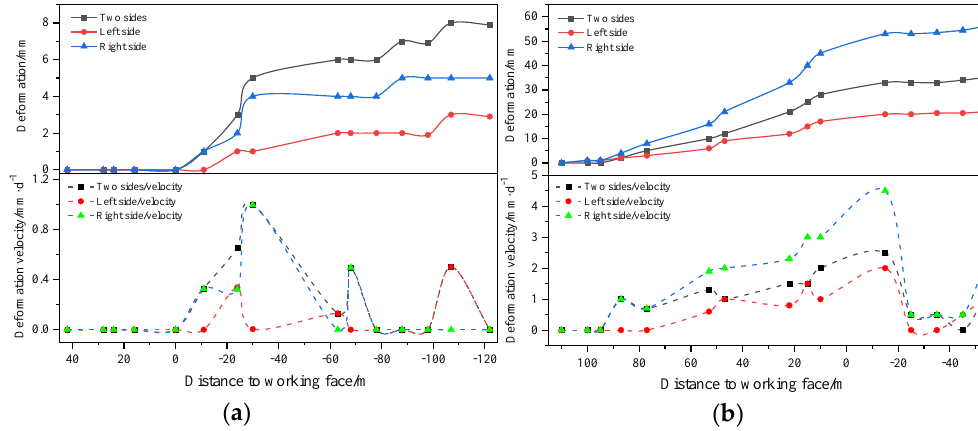
Figure 10. Comparison of deformation amount and deformation velocity of roadway surrounding rock ( a ) measuring point 9# ( b ) measuring point 10#.